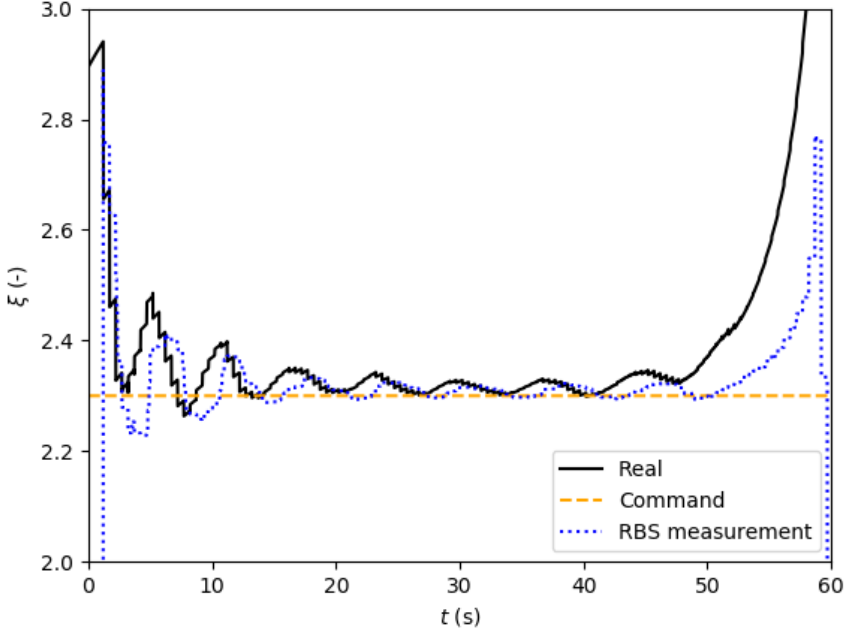
Figure A6. Mixture ratio profile, feedback with downgraded regulation law, case